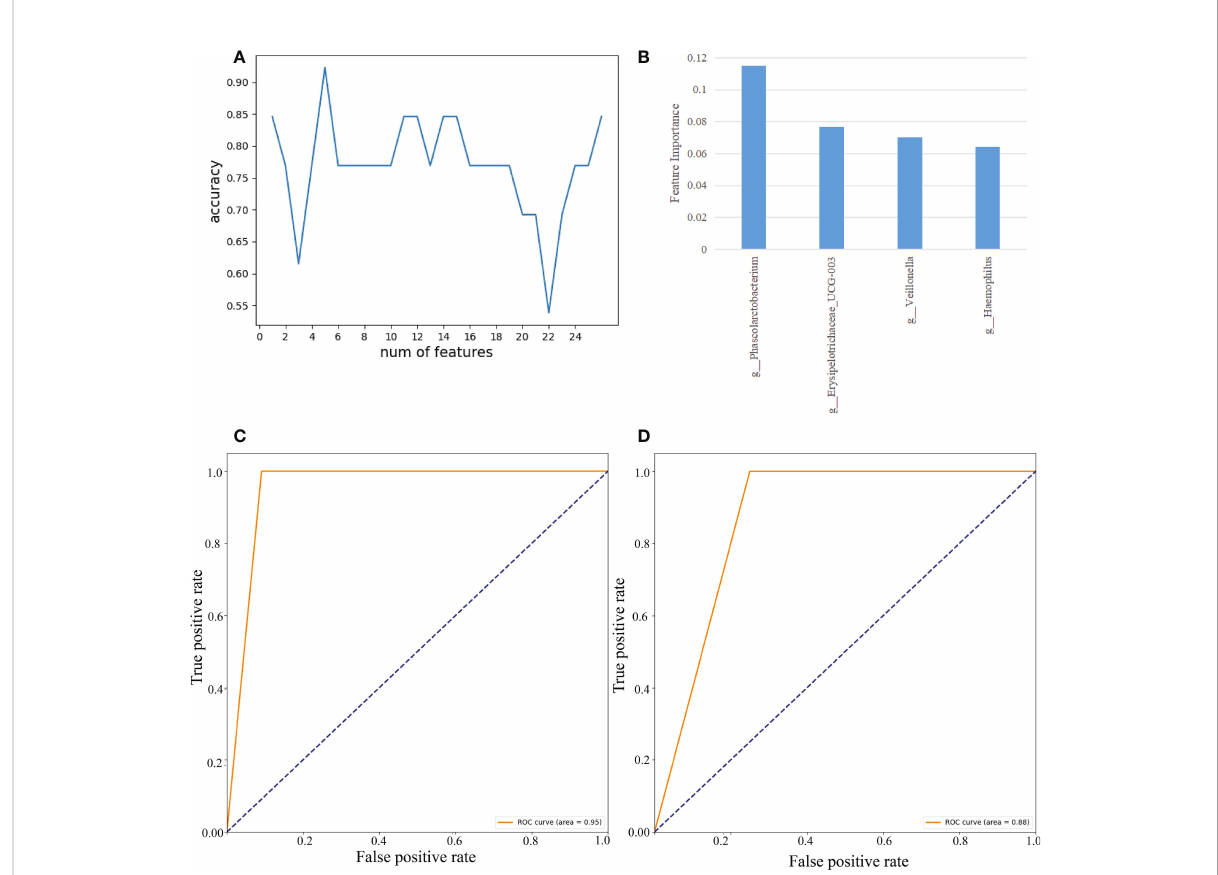
FIGURE 8 Feature selection of fecal gut microbes on the B sample set by using the random forest (RF) and evaluation using the ROC curves. (A) The accuracy changes of classi fi cation model on the B sample set. (B) The importance in descending order(4 gut microbes). (C) Evaluation using ROC curve on the A sample set. (D) Evaluation using ROC curve on the C sample